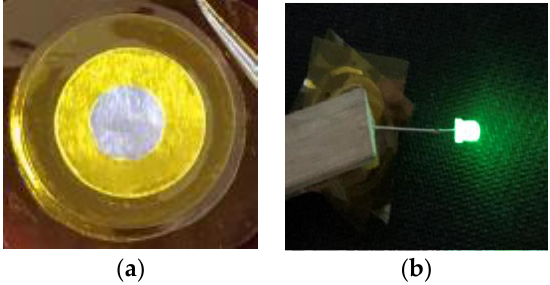
Figure 10. ( a ) Digital photo of EDLC fabricated with the P-40-10 electrolyte system, ( b ) powering a light-emitting diode (LED) with EDLCs connected in series using conductive silver paste.